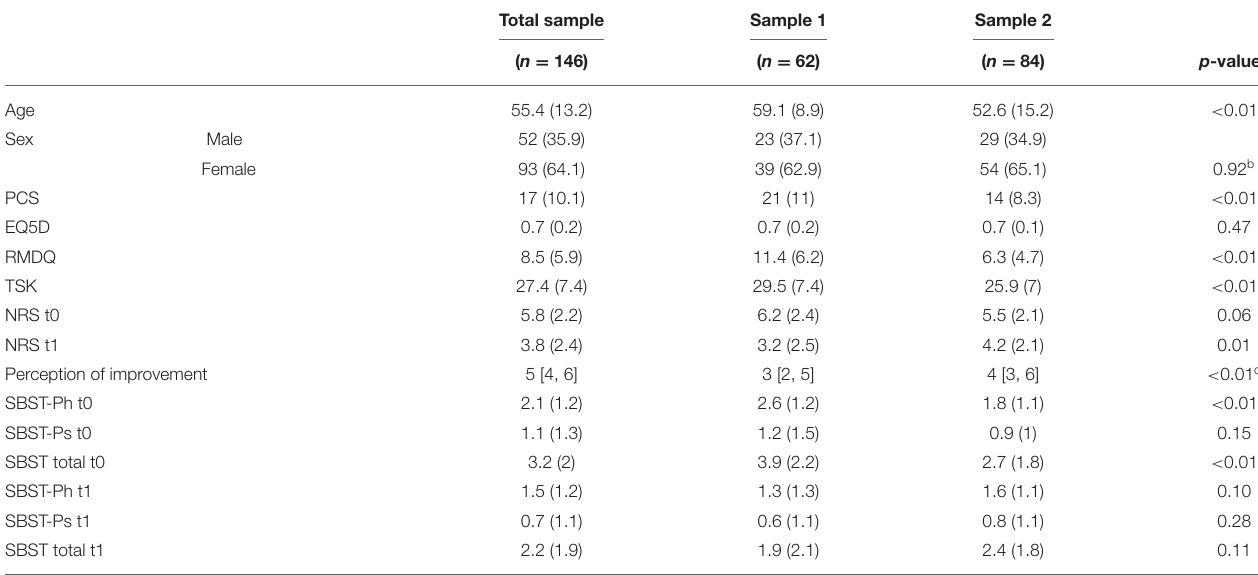
TABLE 1 | Frequencies and descriptive statistics of the sample.